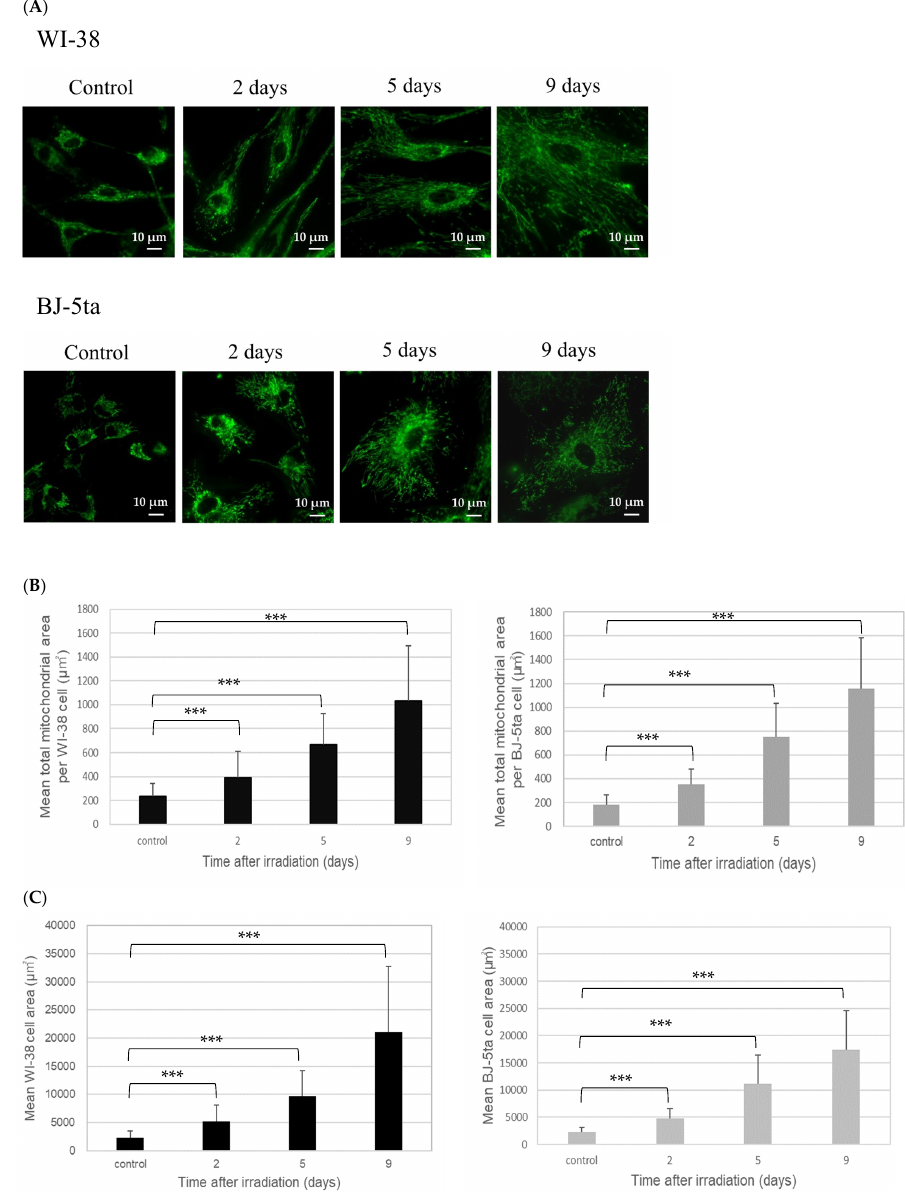
Figure 4. ( A ) Representative images of MTG-stained mitochondria of nonirradiated (control) and 20 Gy X-irradiated WI-38 and BJ-5ta cells observed under a fluorescence microscope at 60 × magnifi- cation. The images of the irradiated cells were taken at 2, 5, and 9 days after irradiation. ( B ) Mean total mitochondrial area per cell. ( C ) Mean cell area (from phase contrast images). The error bars in ( B ) and ( C ) represent the standard deviation ( n = 90). Statistical analysis was performed with one-way ANOVA ( p < 0.001) plus a Student’s t-test. The symbol * indicates the p -values of the t -test compared with the control and irradiated samples, respectively; *** p < 0.001. Table 1. Averaged geometric data of nonirradiated (control) and 20 Gy X-irradiated WI-38 and BJ-5ta cells. The total mitochondrial area was obtained by MTG